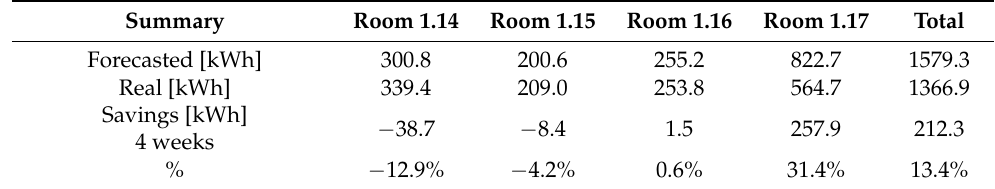
Table 3. Savings on energy for cooling by tackling the behaviour of set point temperature preferences.